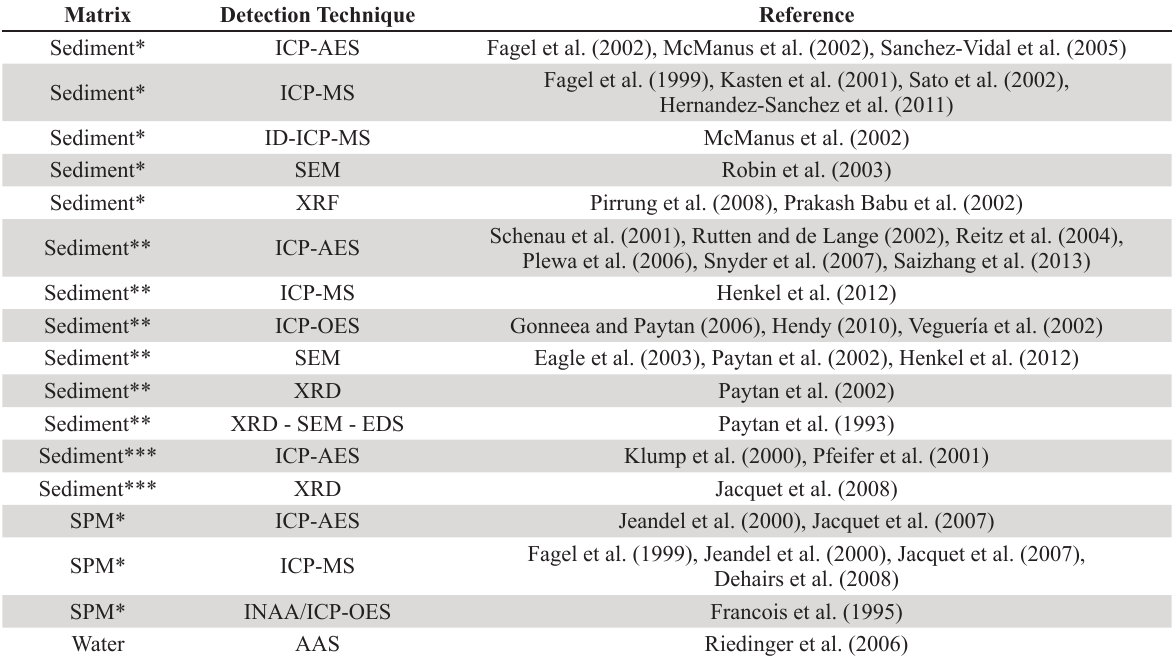
Study matrix analyzed and Ba detection techniques for abiotic